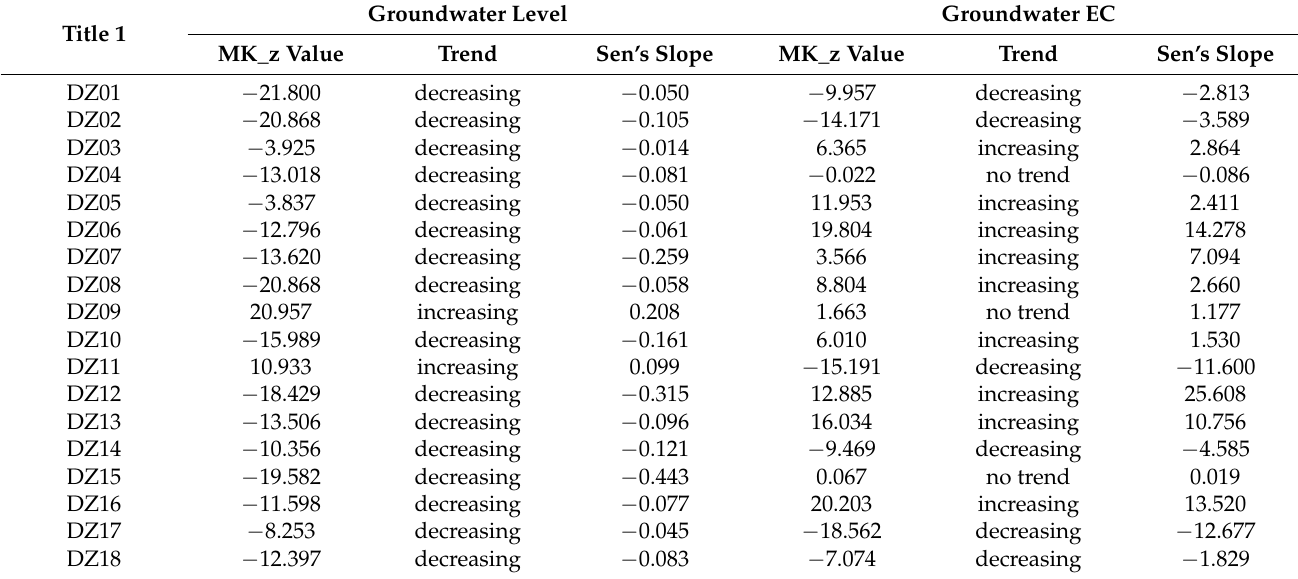
Table 2. The results of MK analysis for trending components of groundwater level and EC.